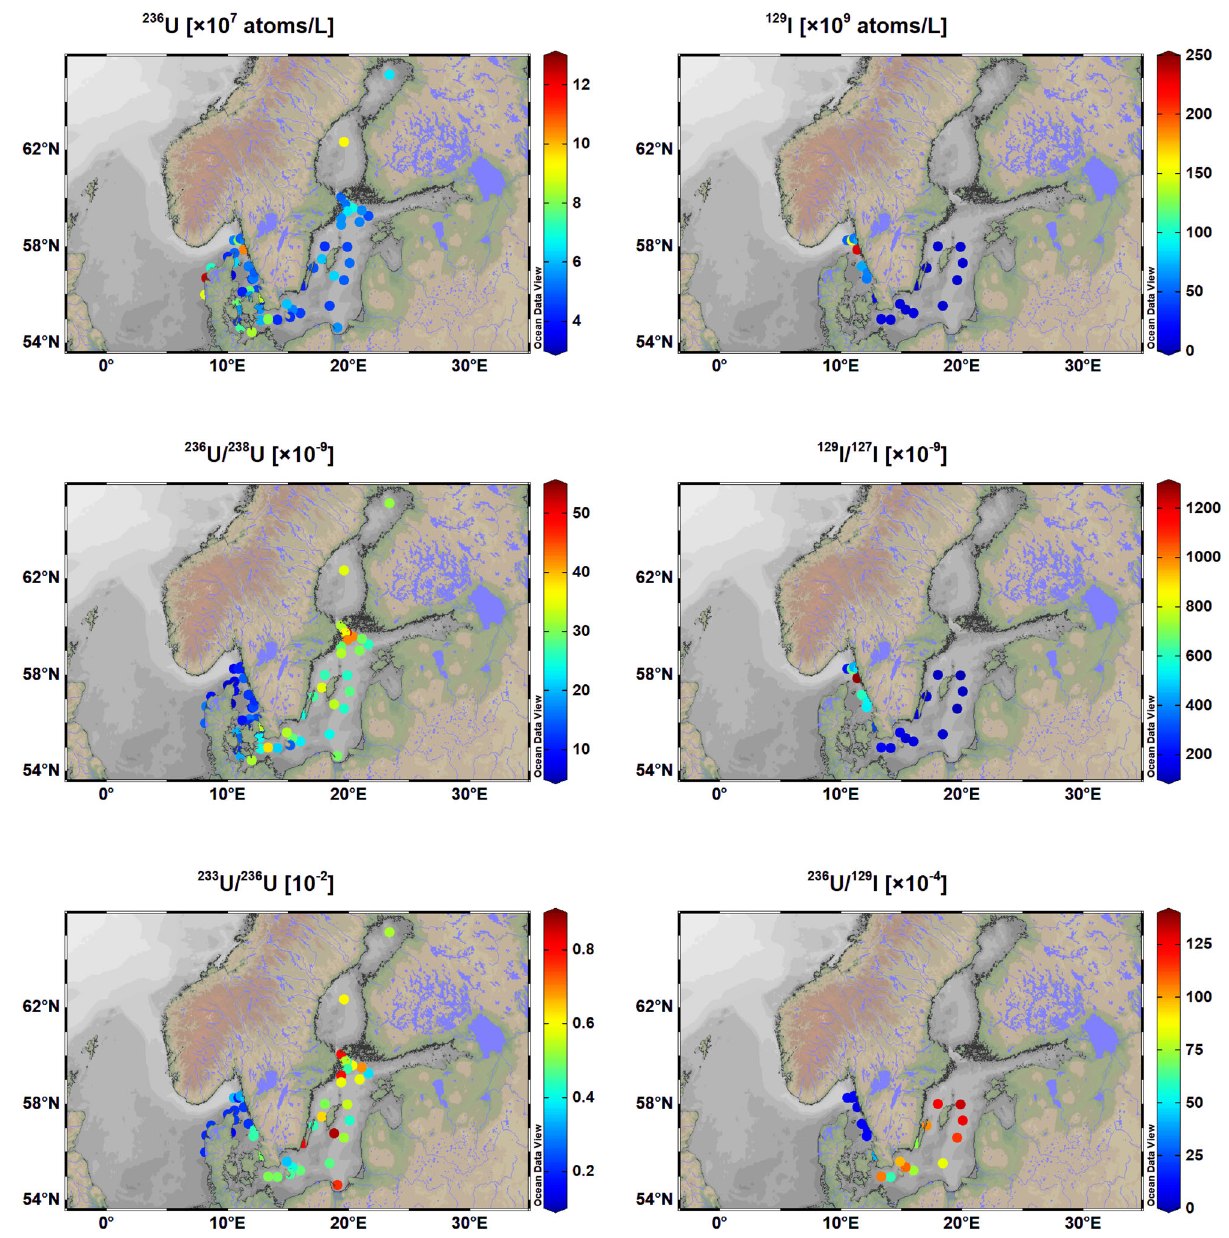
Fig. 2 Results of anthropogenic radionuclides. Distribution of 236 U and 129 I concentrations, and 236 U/ 238 U, 129 I/ 127 I, 233 U/ 236 U, and 236 U/ 129 I atomic ratios in the Baltic Sea surface water during 2011 –